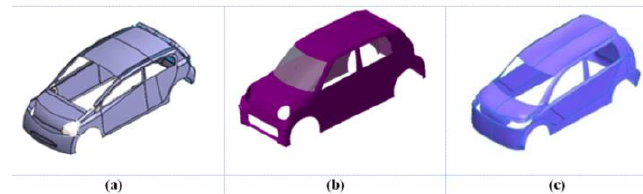
Fig. 3. CAD model of vehicle bodies (a) Daihatsu Mira X, (b) Honda N-One 2013 (c) Suzuki Wagon R 2012